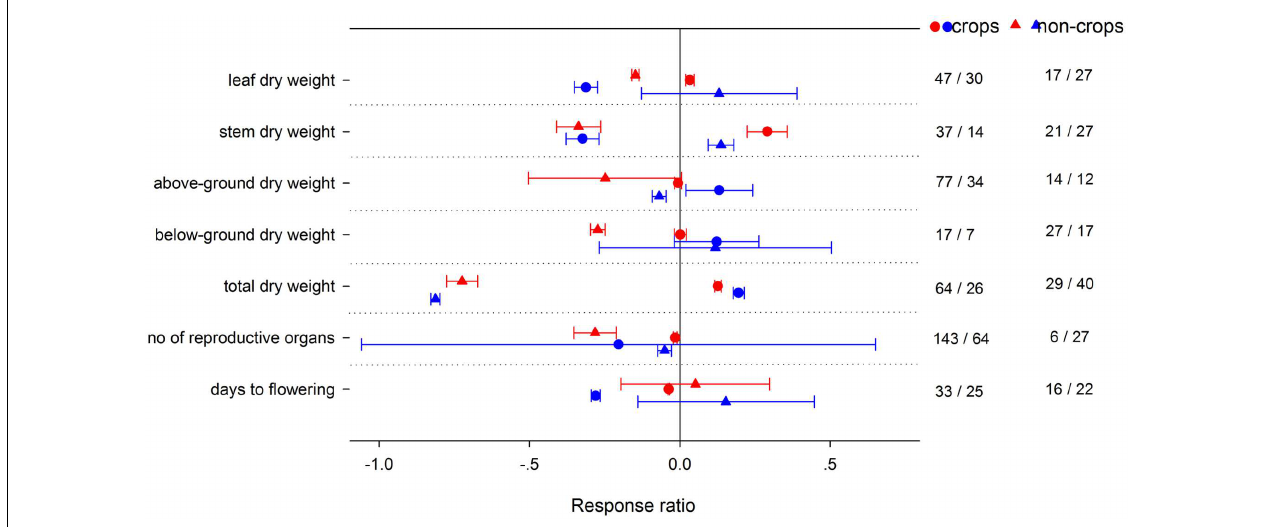
FIGURE 6 | Plant yield-related responses to HNT (red) and LNT (blue) in crops (circles) and non-crops (triangles) species. Each data point represents the mean ± 95% CI. The number of observations for each variable is given on the right of the